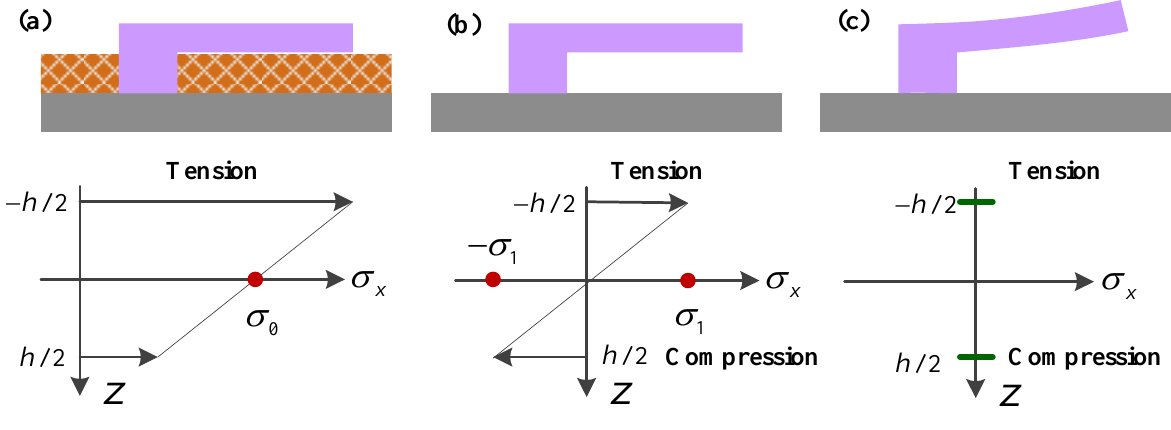
Figure 16. Schematic of residual stress gradient in the cantilever with microfabrication. ( a ) An ideal intermediate state, ( b ) after release and ( c ) before bending. Reused with permission from [224], Copyright 2010, John Wiley and